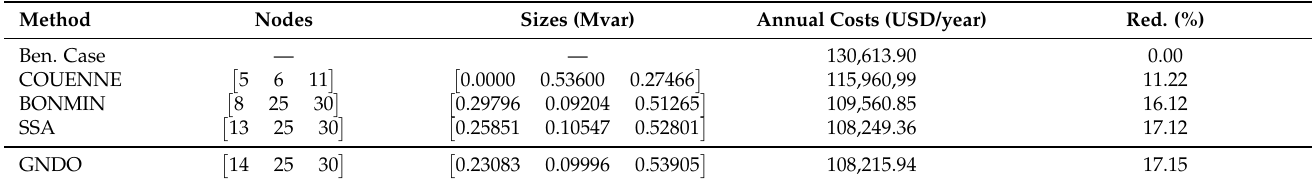
Table 5. Optimal solutions obtained by the studied optimization methods for a radial grid configuration.